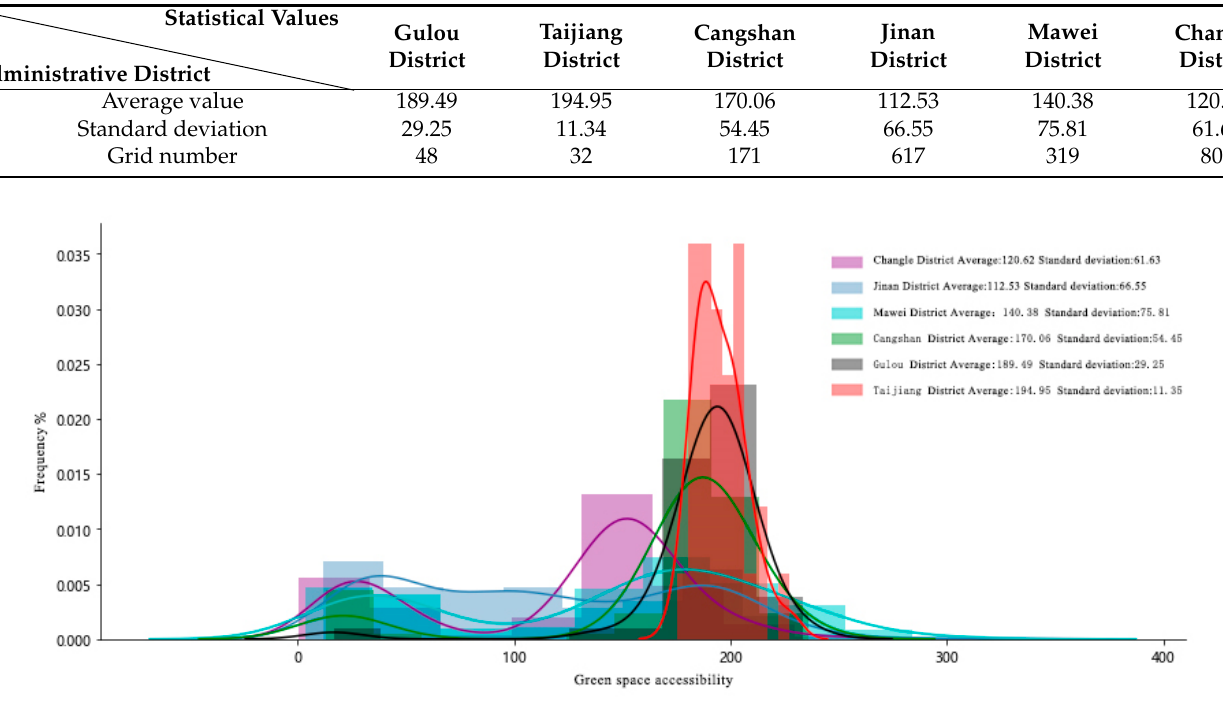
Table 8. Statistical descriptions of green space accessibility in urban areas of Fuzhou. Figure 14. Frequency distribution of green space accessibility in urban areas of Fuzhou.